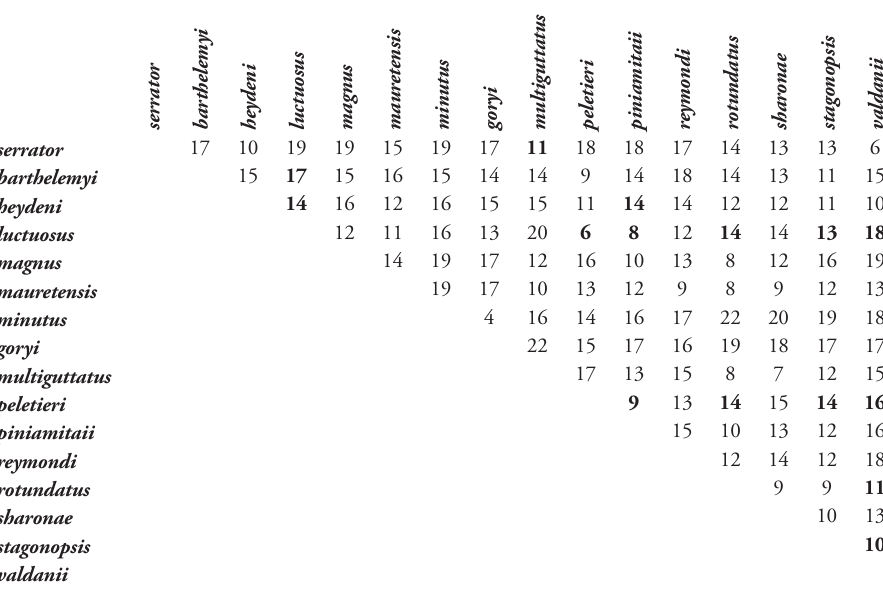
Pronotum transverse and cordiform, slightly convex, usually ornamented by colored scales at the lateral bead, disc with or without scales. Anterior and posterior angles obtuse. Scutellum triangular, small and short, often hidden by the pronotal base. Flight- less. Elytra wide and oval, slightly convex, coalesced along suture, humeri completely rounded; surface covered by dense or sparse scales, white scales creating longitudinal stripes on the radial field and spots on the disc; apex almost truncate. Pygidium not covered by elytra, last visible tergite with colored